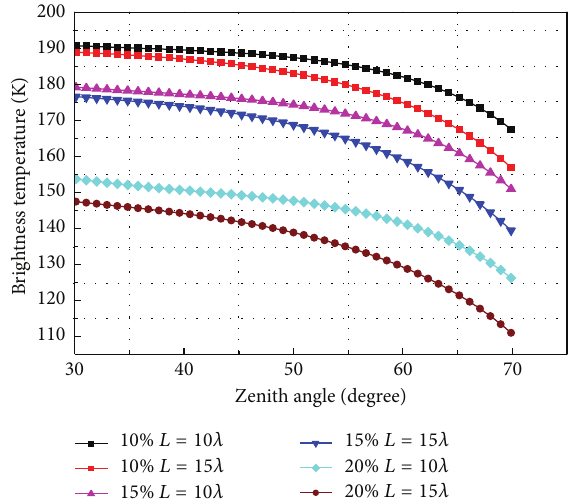
Figure 18: Comparison of different RMS heights of wet soil with different moisture content, in which the correlation length of 𝐿 is 10 𝜆 , and the relative complex permittivity of 10% humidity, 15% humidity, and 20% humidity is set as 2.1- j 0.9, 3.0- j 1.23, and 1.73- j 3.0.